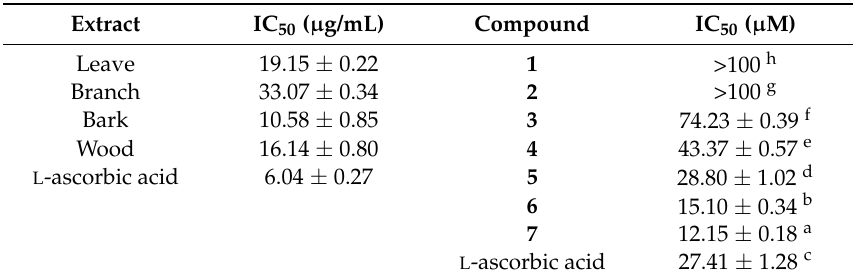
Table 1. IC 50 values for DPPH radical scavenging activity from different parts of QG plants and from isolated compounds. Extract IC 50 ( µ g/mL) Compound IC 50 ( µ M) 19.15 ±